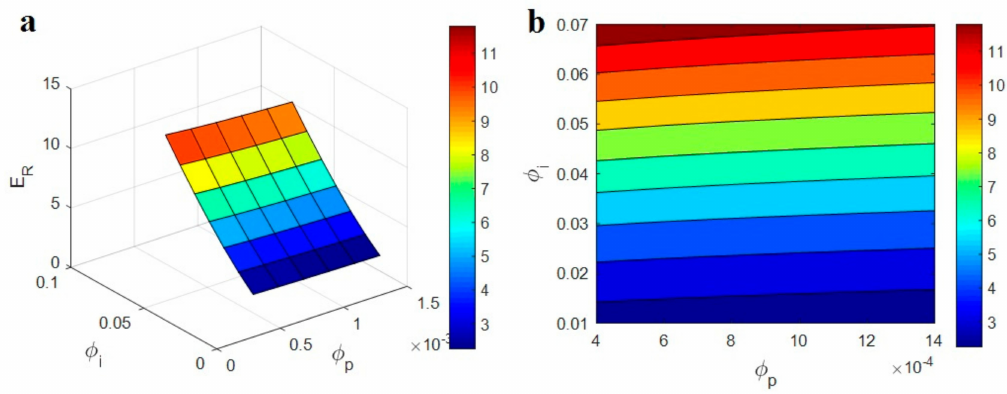
Figure4. ( a )3Dand( b )contourplotsforthee ff ectsof“ φ p ”and“ φ i ”parametersontherelativemodulus.